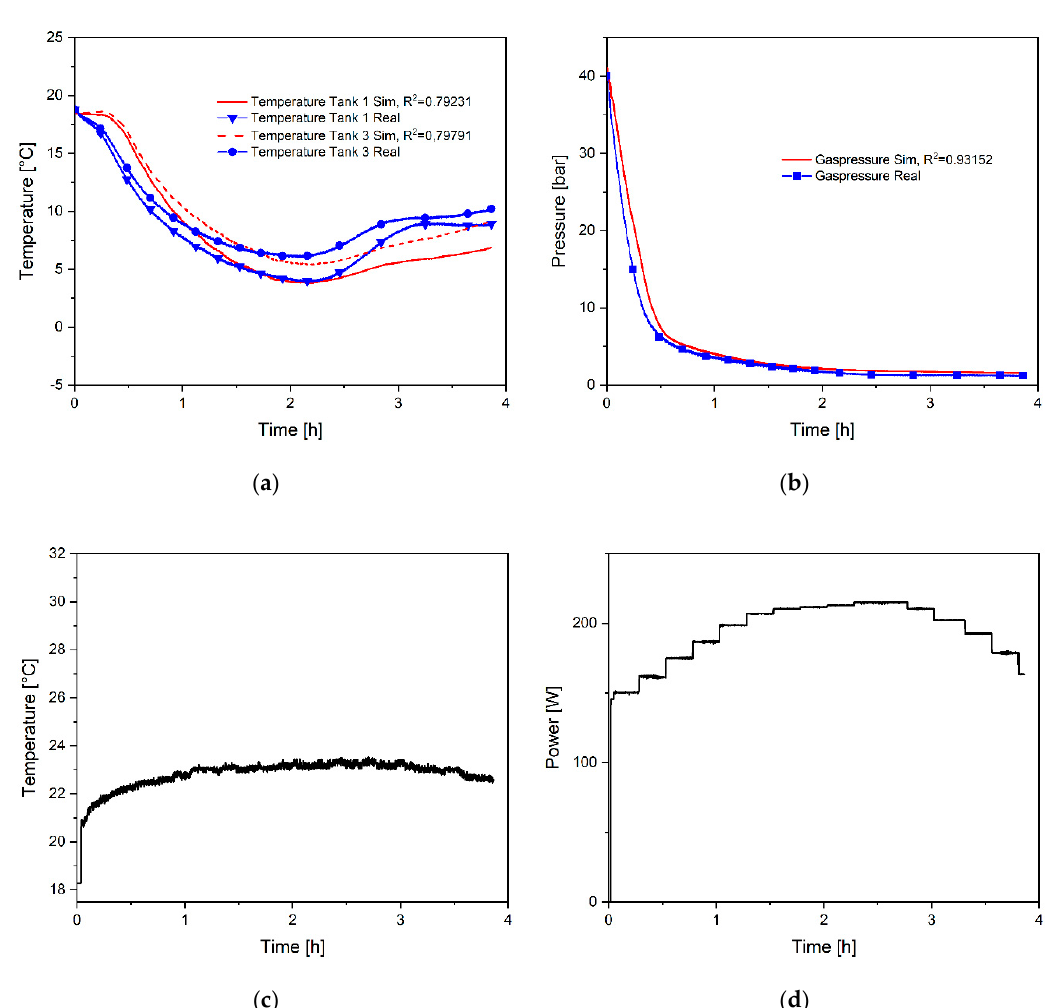
Figure 9. Variable dynamic load conditions: ( a ) Simulated (Sim) and measured (Real) temperature development of tanks 1 and 3, ( b ) Simulated (Sim) and measured (Real) system pressure ( c ), temperature of the air stream coming from the fuel cell, and ( d ) power of the fuel cell.